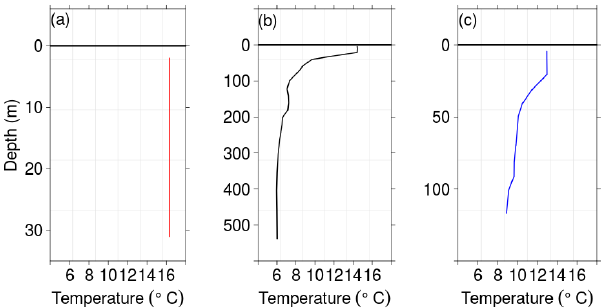
Figure 2. Temperature profiles as recorded by a CTD cast for (a) Station 11 (SNS), (b) Station 65 (SKNT), and (c) Station 80